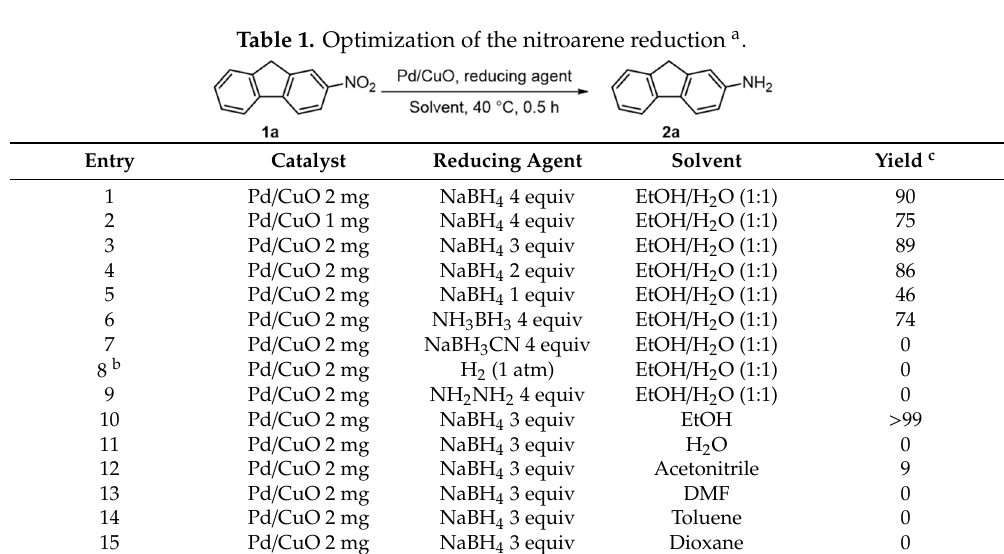
Table 2. Evaluation of the scope of the nitroarene reduction a